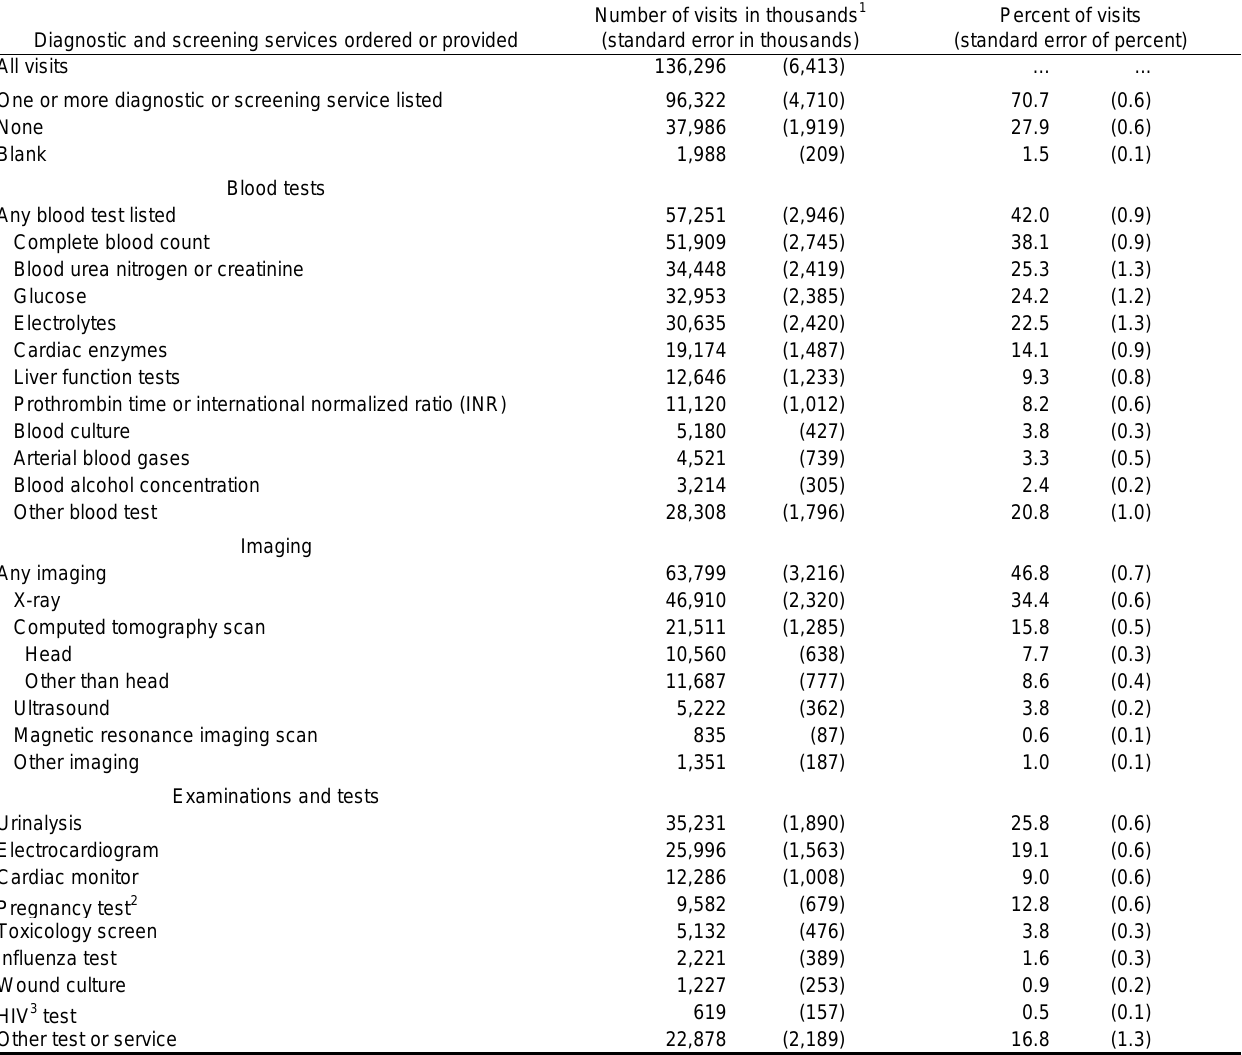
Table 18. Selected diagnostic and screening services ordered or provided at emergency department visits: United States,